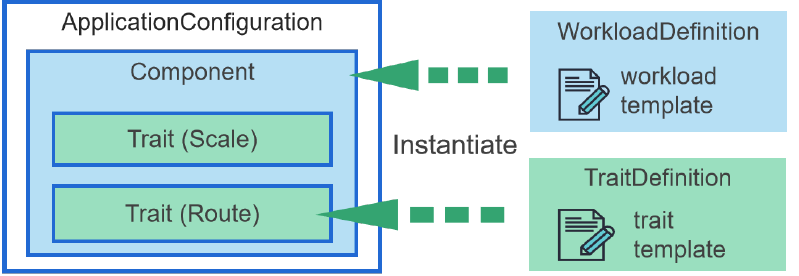
Figure 2. OAM application configuration